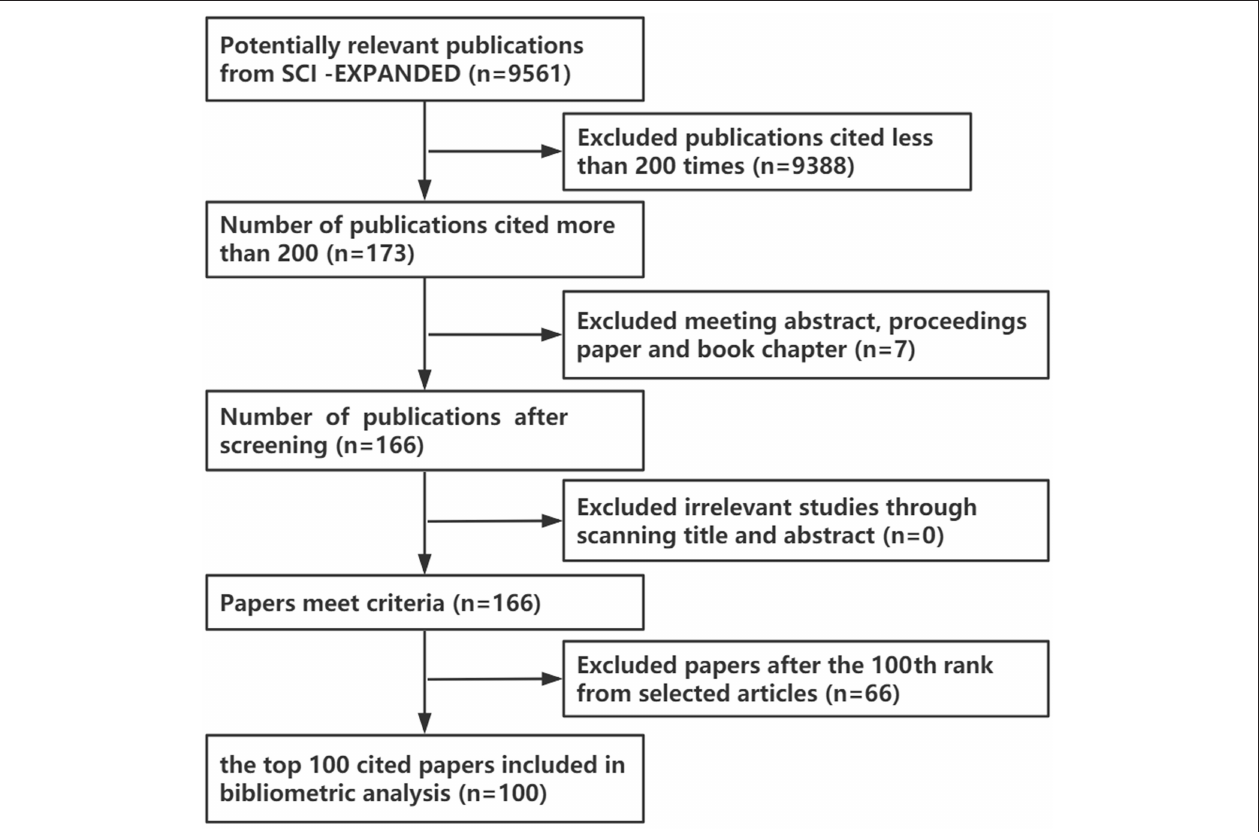
FIGURE 1 | Data extraction